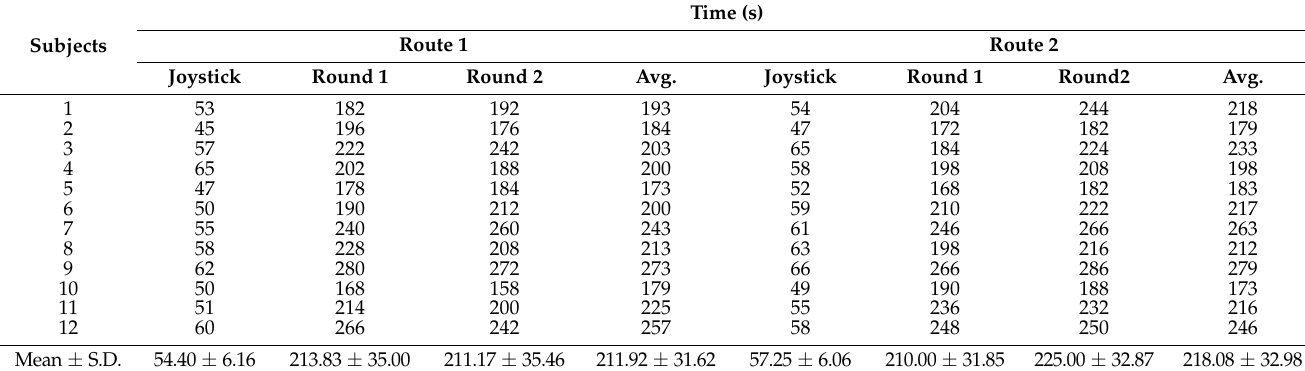
Table 5. The average times taken by all subjects to complete routes 1 and